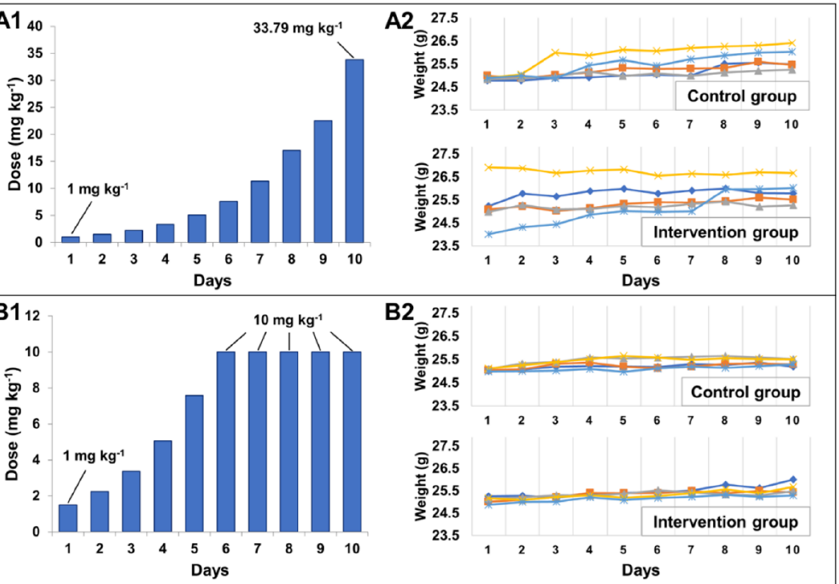
Figure 5. Cell viability of 3T3 fibroblast cell line incubated for 24 h with different concentrations of part -CaF 2 . The experiments were performed in 6 replicates.